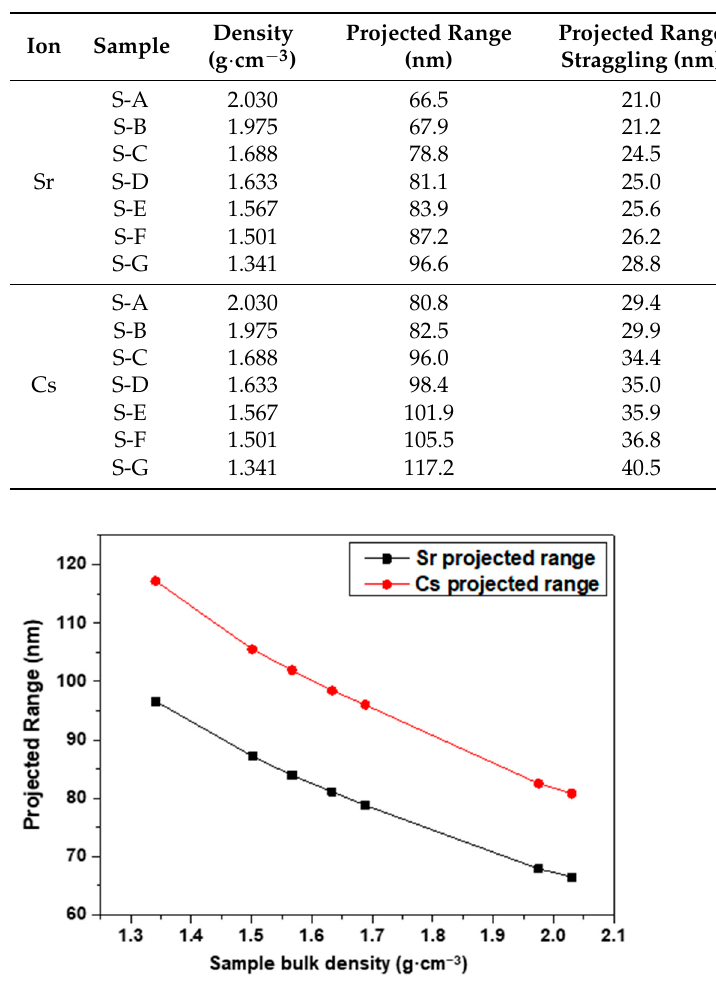
Figure 7. Depth profile of ( a ) Cs and ( b ) Sr in different clay samples. Table 1. Simulation result of the four moments of Cs and Sr ions distribution in different clay samples.